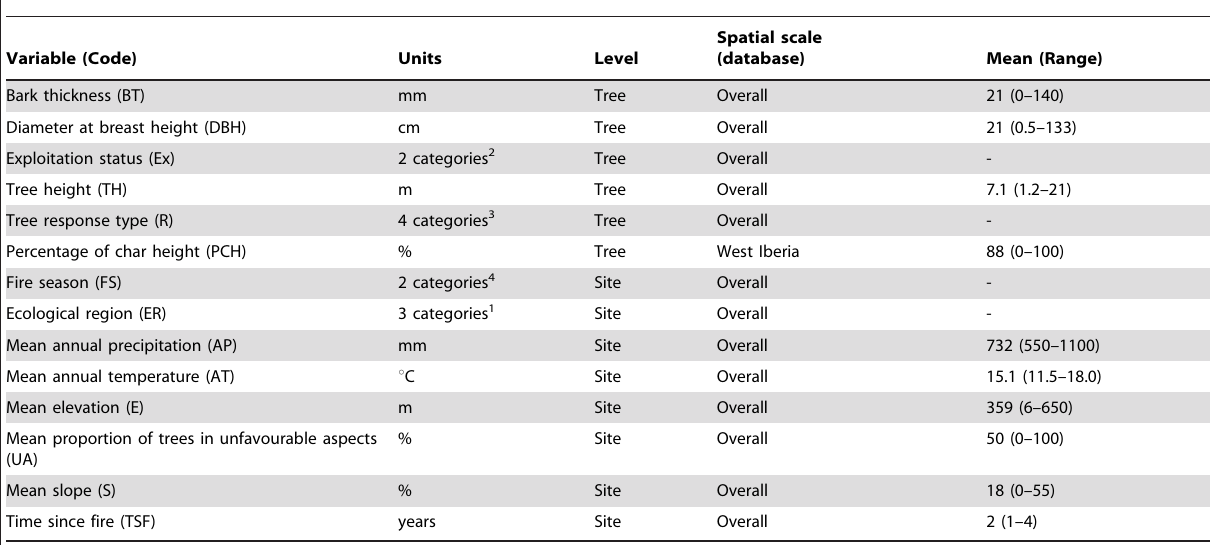
Table 1. Summary of the variables